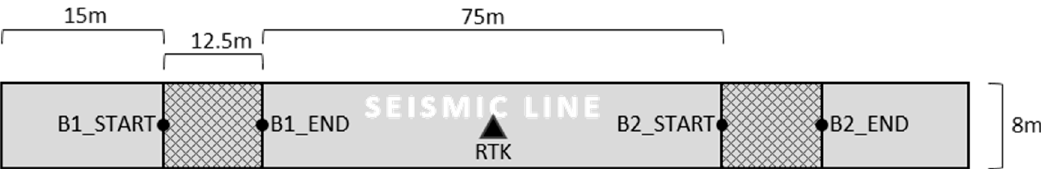
Figure A2. Belt plot design for disturbance sampling. The belts have 100 m 2 area and the same width as the seismic line, the first belt starts 15 meters away from the start of the line, the second belt starts 75 meters away from the end of the first belt. A real-time kinematics (RTK) base-station is located somewhere close to the site for good signal with a rover sensor which was used to collect the coordinates of the start and end points.